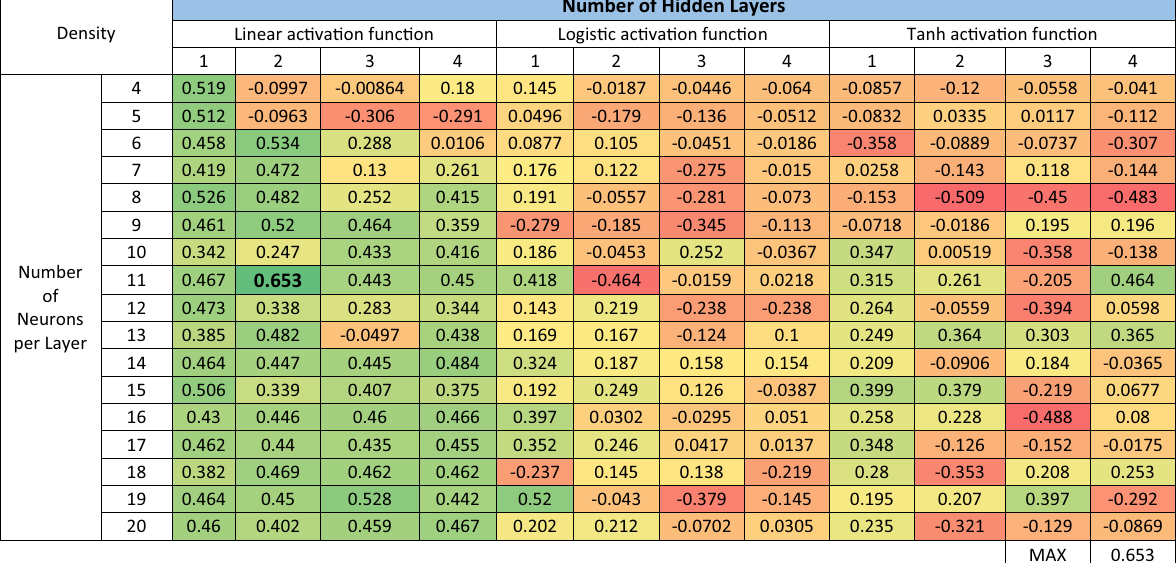
Number of Hidden